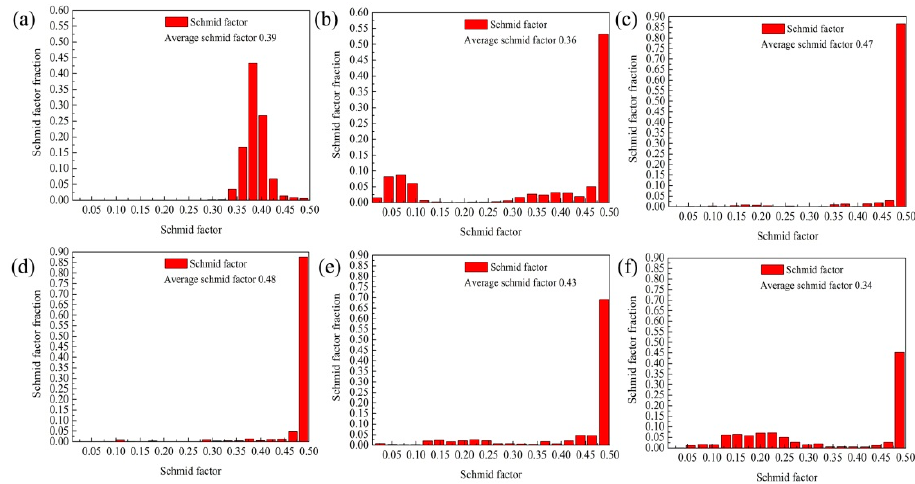
Figure 13. B 2 phase mean Schmid factors of the {110} < 001 > slip system of the Ti 2 AlNb samples subjected to various deformation degrees and subsequent annealing at 900 °C for 2 h: ( a ) as-rolled, ( b ) 25%, ( c ) 50%, ( d ) 60%, ( e ) 65%, and ( f ) 75%.